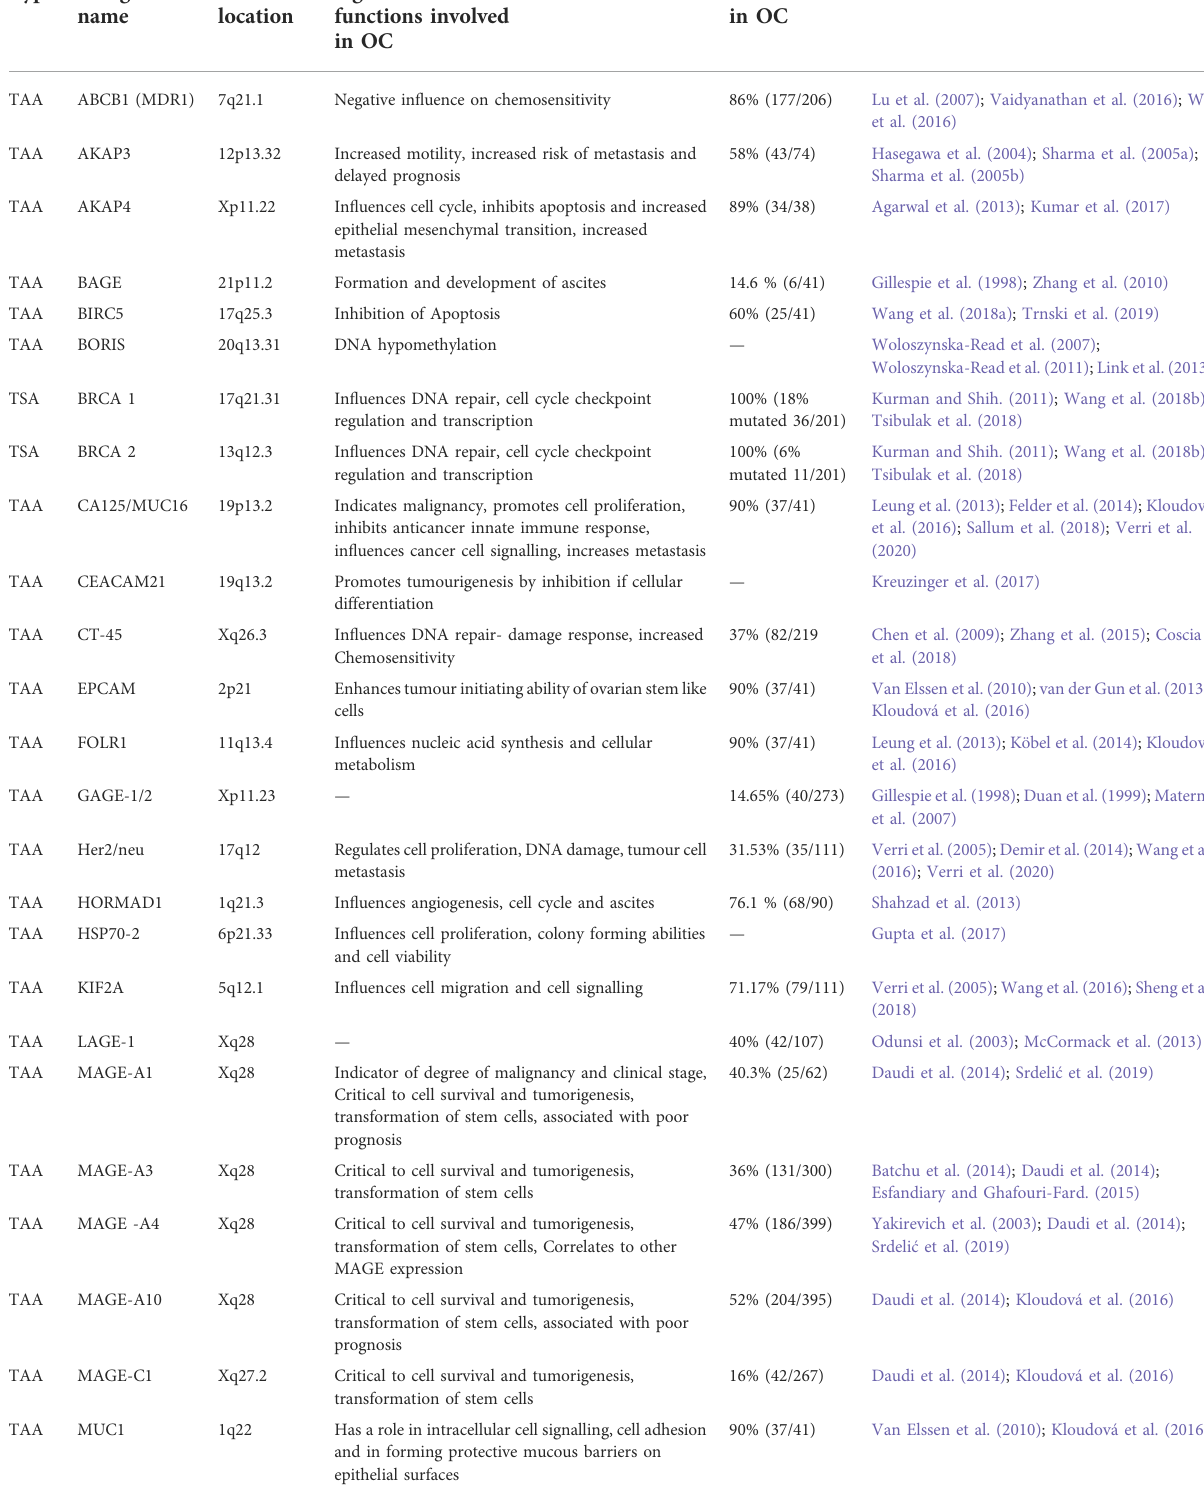
TABLE 1 Table of identi fi ed antigens in Ovarian cancer. These antigens are either mutated or overexpressed in the various types of the ovarian carcinomasandcanserveaspotentialtargetsforimmunotherapyagainstovariancancercells.Theblankspacesindicatethatthesigni fi canceand precise role of the genes in OC is not known and yet to be